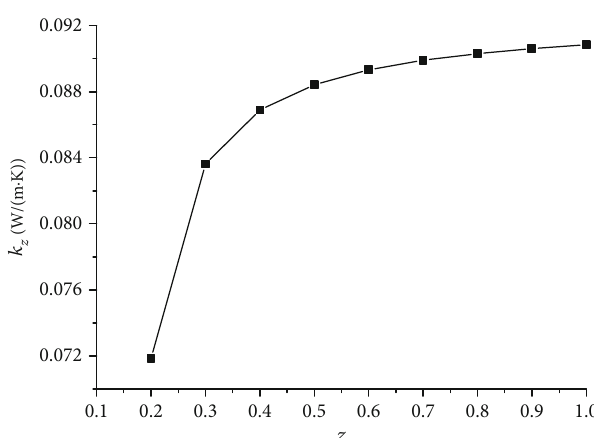
Figure 10: Variation of equivalent thermal conductivity with microsphere range.